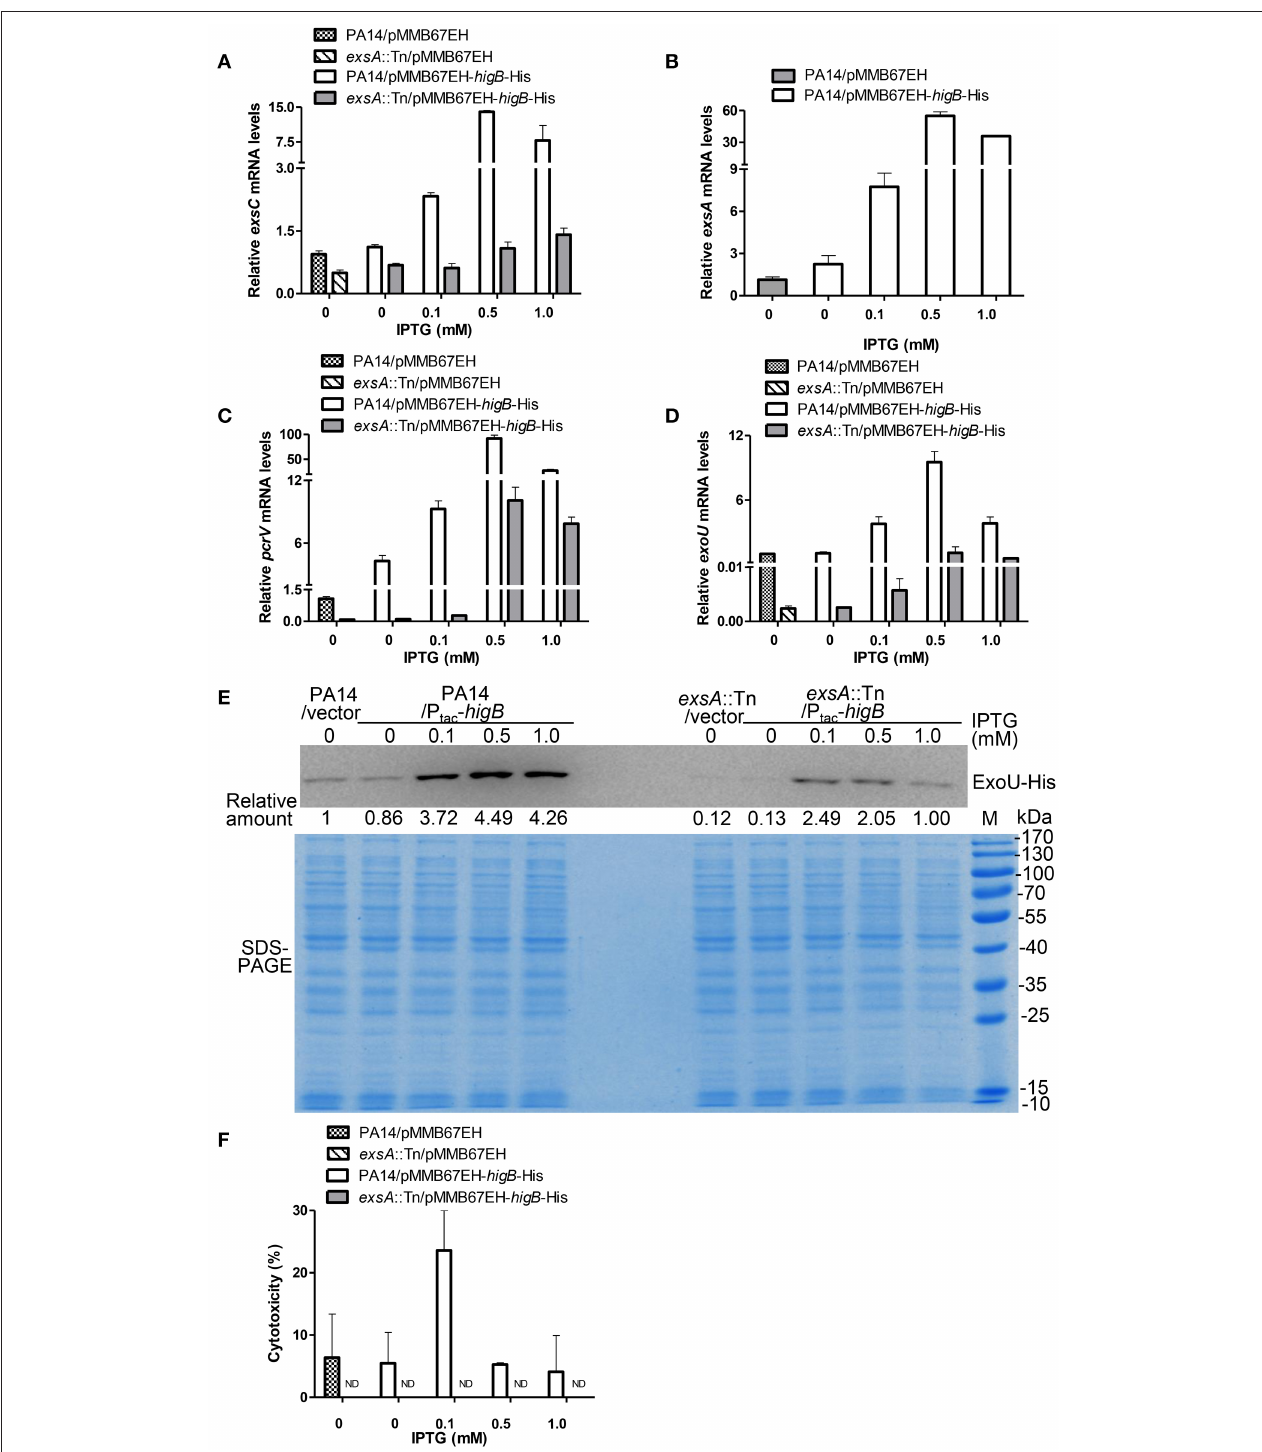
FIGURE 4 | HigB promotes T3SS mediated cytotoxicity. Wild type PA14 and an exsA ::Tn mutant containing pMMB67EH- higB -His or pMMB67EH was grown in the presence of indicated concentrations of IPTG for 3h. Quantitative RT-PCR was used to determine the relative mRNA levels of exsC (A) , exsA (B) , pcrV (C) , and exoU (D) . (E) PA14 or exsA ::Tn containing exoU -His driven by its native promoter (P exoU -exoU -His) and pMMB67EH- higB or pMMB67EH was grown in the presence of indicated concentrations of IPTG for 3h. Samples from equivalent bacterial cells were loaded into SDS-PAGE gels and stained with Coomassie blue or probed with an anti-His antibody. The relative density of each band was determined by Image J. (F) Raw264.7 cells were infected with the bacteria at an MOI of 10 for 3.5h, followed by LDH release assay. ND, not detectable.